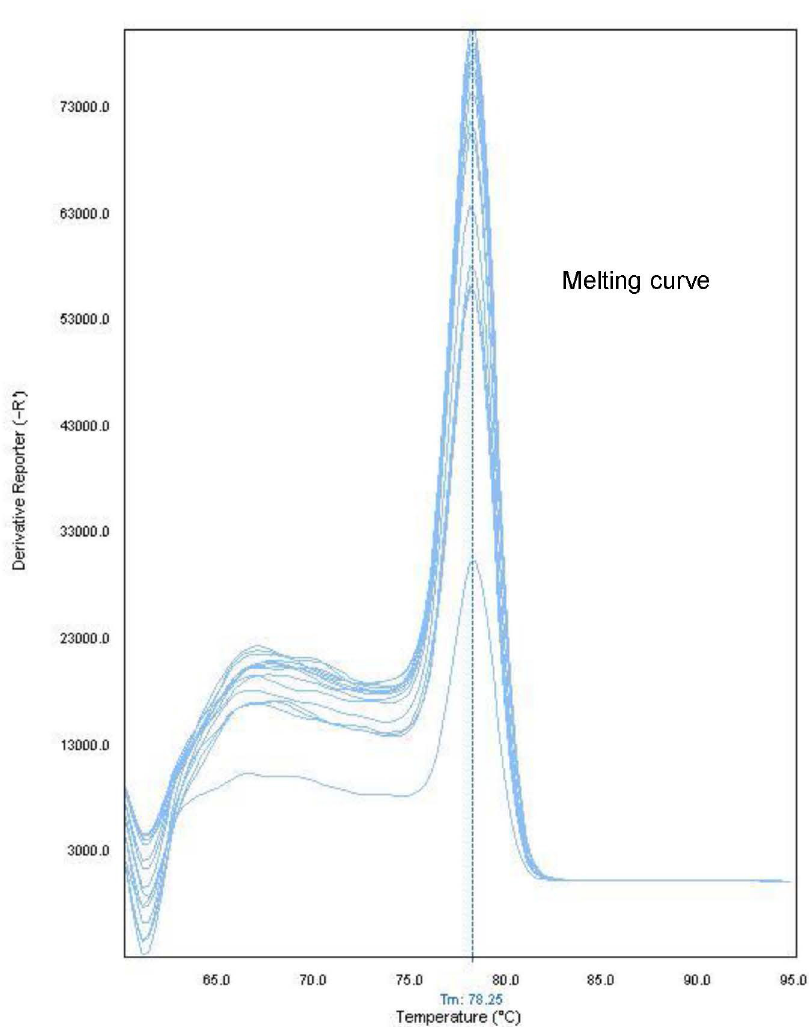
Fig 4. Composite overlay of RT-qPCR melting curves performed by the Step One Plus. Ten-fold serial dilutions of standard RNA control generated a unique melting point temperature (~Tm 78°C) for all concentrations of